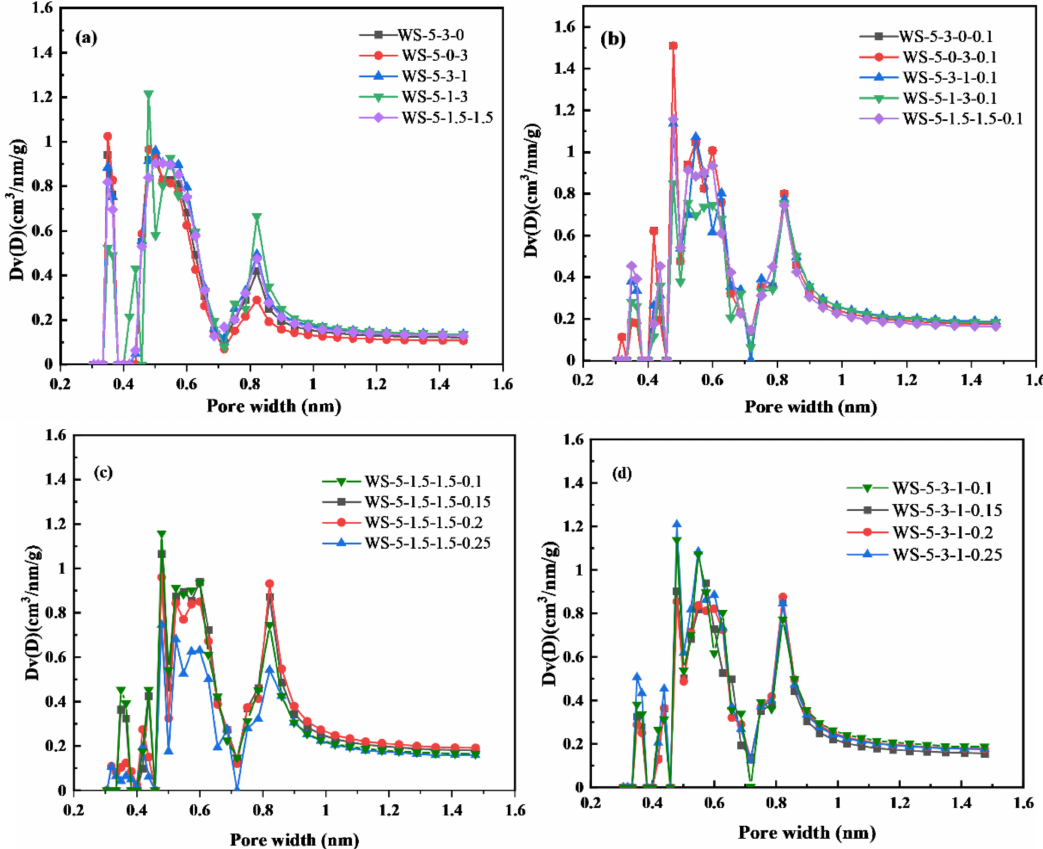
Figure 7. NMPSD plot of ( a ) biochar with different amounts of metal salts activation, ( b ) biochar with different amounts of metal salts and 0.1 mL min − 1 H 2 O(g) activation, ( c ) WS-5-1.5-1.5 with different amounts of H 2 O(g) activation, and ( d ) WS-5-3-1 with different amount of H 2 O(g) activation. The pore sizes were from 0.3 nm to 1.0